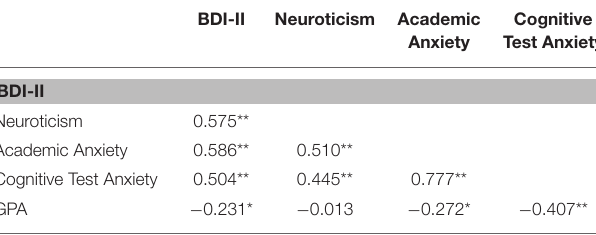
TABLE 3 | Correlation summary